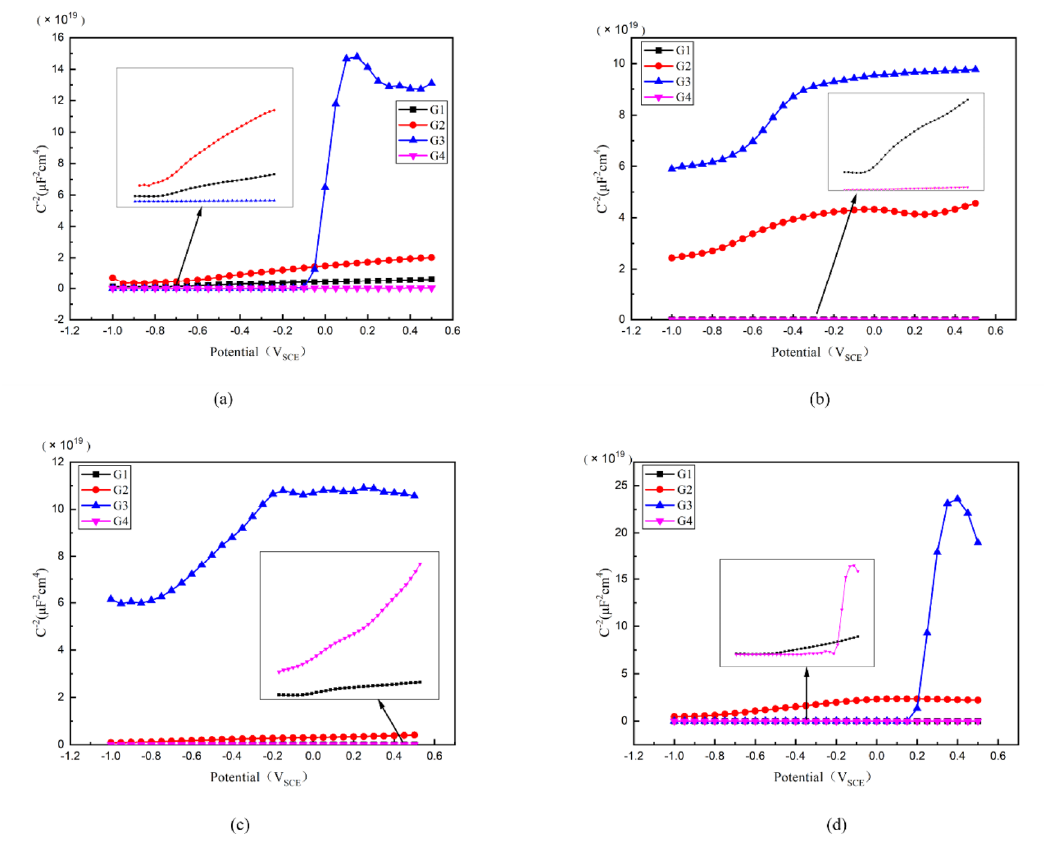
Figure 12. Each EP/CeO 2 -GO coating’s Mott–Schottky pattern for immersion for 2 d, 8 d, 16 d, 24 d: ( a ) Mott–Schottky pattern for 2 d; ( b ) Mott–Schottky pattern for 8 d; ( c ) Mott–Schottky pattern for 16 d; ( d ) Mott–Schottky pattern for 24 d.